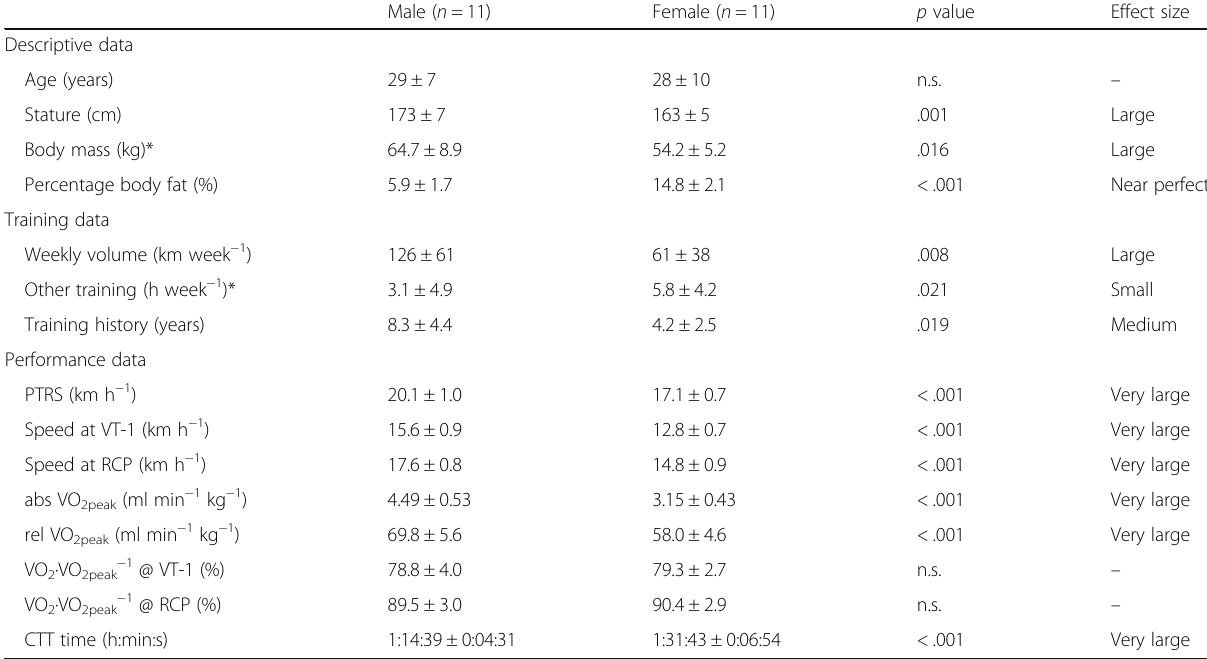
Table 1 Sex comparison of anthropometric, training, and performance